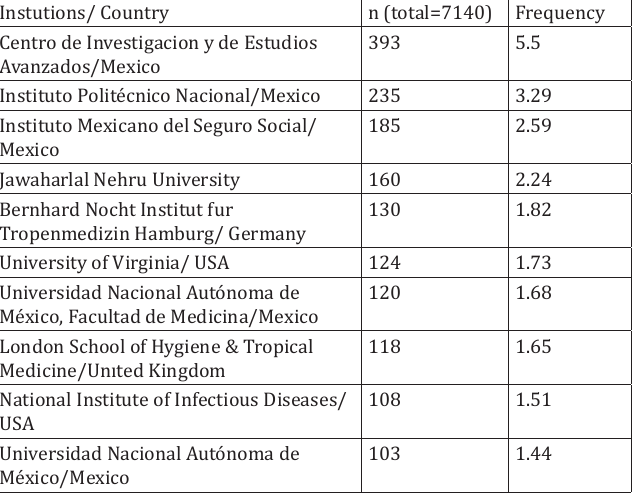
The leading instutions on amebiasis research.